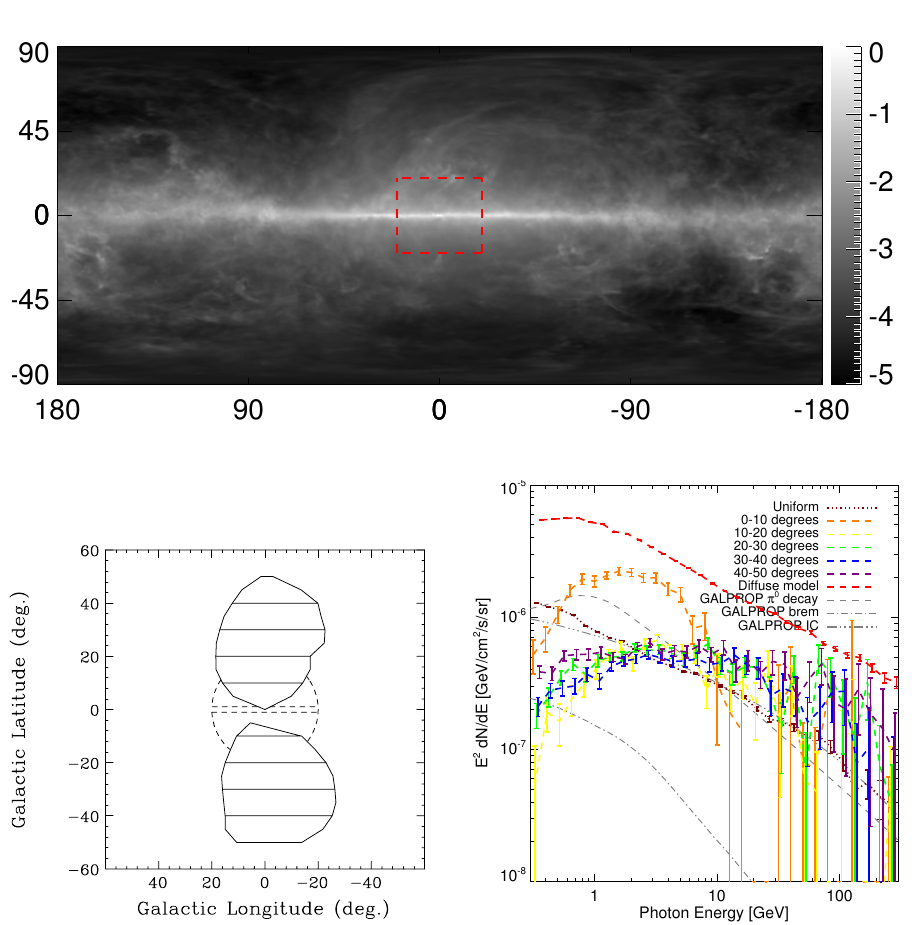
Figure 14: Top: p6v11 Fermi Collaboration model for the diffuse gamma-ray emis- sion, evaluated at an energy of 1 GeV; the x and y axes denote Galactic latitude and longitude respectively, and the red dashed lines indicate a 40 × 40 ◦ region around the Galactic Center (reproduced from Ref. [ 199 ] ). Bottom left: spatial template for the Fermi Bubbles. Horizontal lines indicate ten-degree bands in Galactic latitude. Dashed lines indicate the region within 20 ◦ of the Galactic center, but more than 1 ◦ from the Galactic plane. Bottom right: Spectra extracted from a template fit, mod- eling the sky as a linear combination of the diffuse model shown in the top panel (red dashed line), the isotropic gamma-ray background (brown dotted line), and the latitudinally sliced templates for the Fermi Bubbles shown in the bottom left panel (or- ange, yellow, green, blue and purple dashed lines, for latitudes of 0 − 10 ◦ , 10 − 20 ◦ , 20 − 30 ◦ , 30 − 40 ◦ , 40 − 50 ◦ respectively). Gray lines indicate the expected spectra from cosmic rays interacting with the gas and starlight. Reproduced from Ref. [ 200 ] ; see that work for